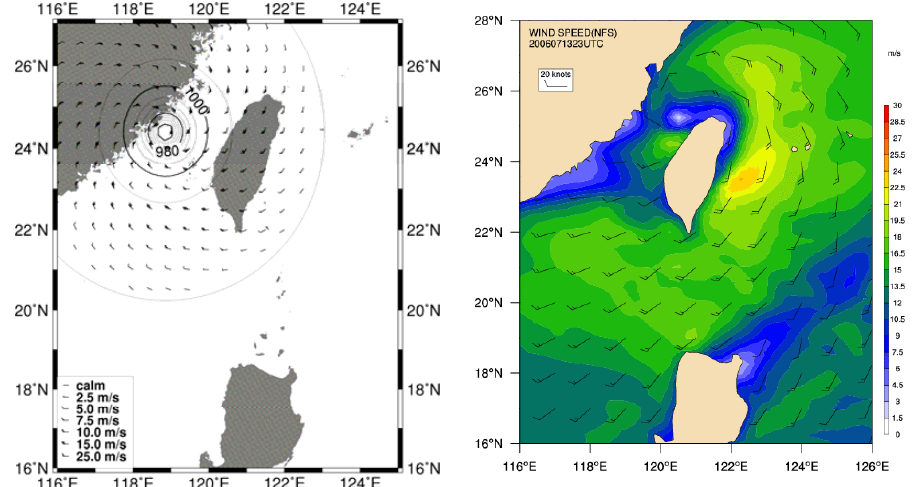
Figure 6 Comparison of modeled wind field (left) and atmospheric model derived Fig. 6. Comparison of modeled wind field (left) and atmospheric model derived (AMD) wind field (right). The AMD wind field reasonably simulates the wind distortion when a typhoon passes through the high mountains in central Taiwan. (AMD) wind field (right). AMD wind field reasonably simulates the wind distortion when typhoon passes through high mountain in central Taiwan.